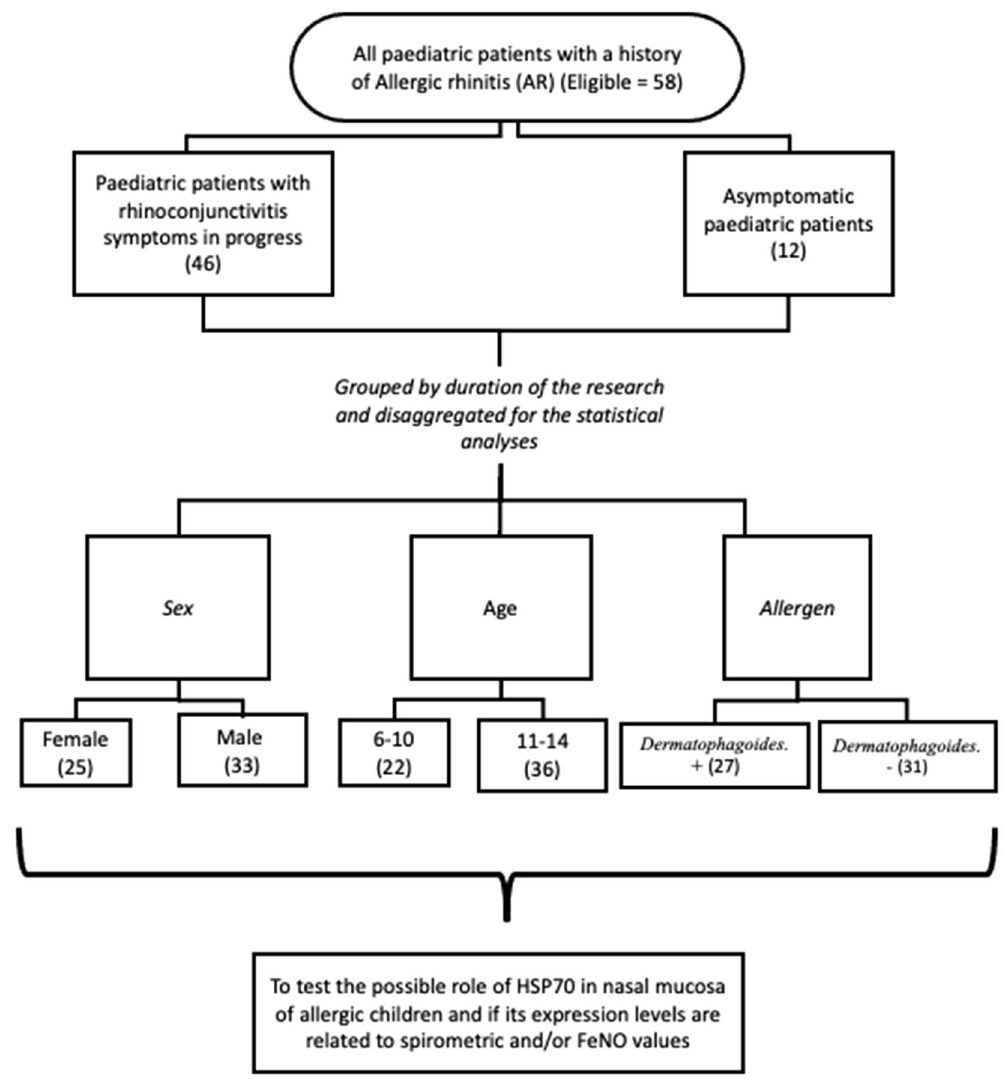
Figure 6. Flow chart reporting patient’s enrollment in the